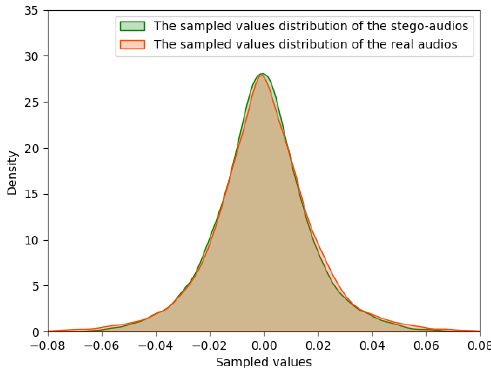
Figure 7. The distributions of the stego-audios and real audio